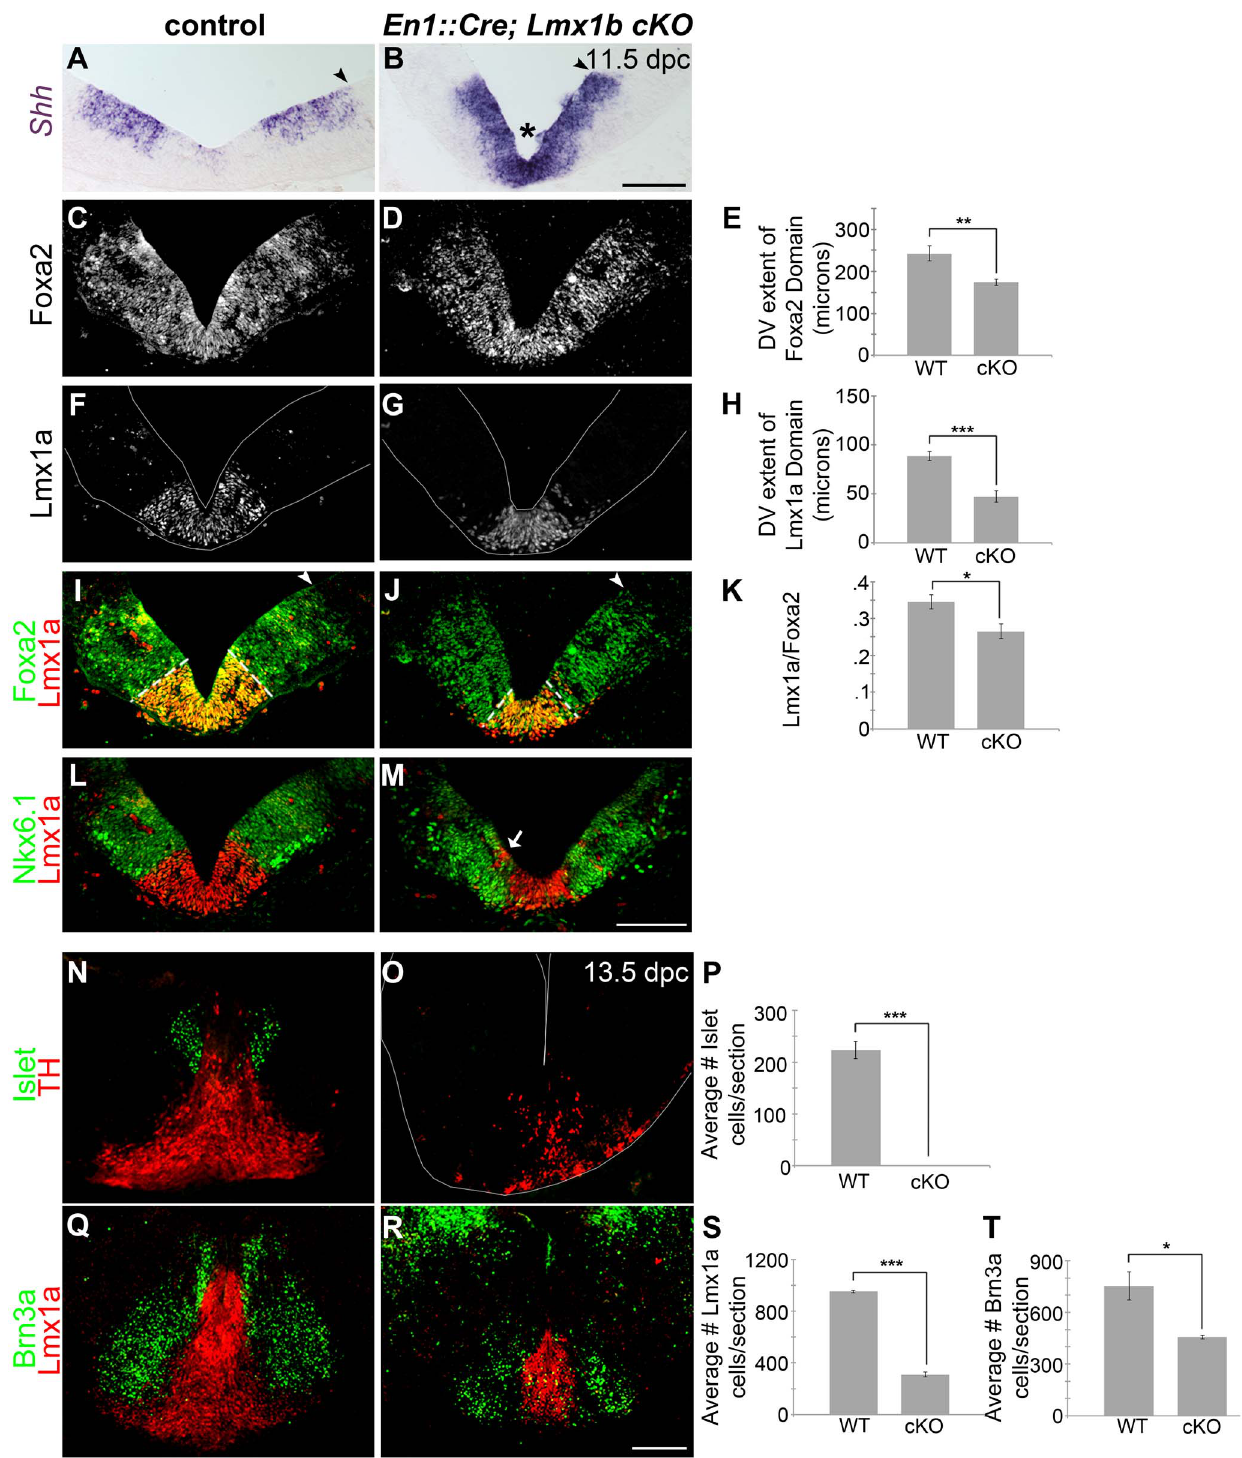
Figure 6. Loss of Lmx1b alters the size of the FP, the mDA progenitor domain, and ventral midbrain patterning. (A–B) In 11.5 dpc En1::Cre,Lmx1bcKO embryos, the cumulative Shh domain is reduced along the dorsal-ventral axis (black arrowheads), but Shh is robustly maintained at the midline (asterisk), indicative of reduced Wnt signaling. (C–M) Immunolabeling revealed a reduction in the size of the Foxa2 and Lmx1a progenitor domains. The closed white arrowheads indicate the dorsal border of Foxa2 expression, graphically represented in E (n=3; control mean=242.84 6 17.51 m M, mutant mean=174.10 6 7.10 m M; p-value=0.002). The dotted white lines indicate the dorsal border of Lmx1a expression, graphically represented in H (n=3; control mean=88.69 6 4.69 m M, mutant mean=47.42 6 5.66 m M; p-value=0.0004) and as a normalized ratio in K (p-value=0.05). The main Lmx1a domain is reduced in size, but a few Lmx1a + cells were observed within Nkx6.1 + territory (white arrow). The Nkx6.1 domain encroaches on the outer edges of the normal Lmx1a domain, and is only modestly reduced in size. (N–T) In 13.5 dpc En1::Cre;Lmx1bcKO